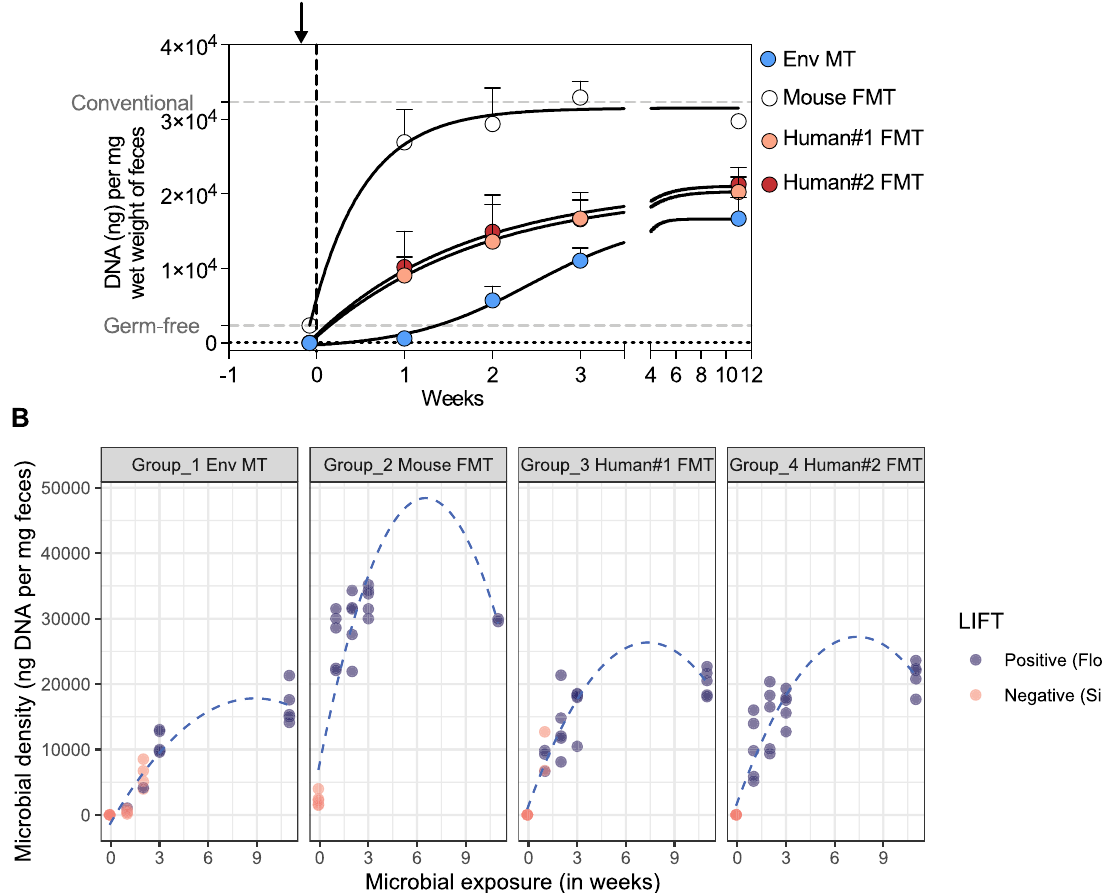
Figure 7. Levô in fimo test and gut microbial colonization kinetics. ( A ) Gut-colonization kinetics in Env MT, mouse FMT, human FMT#1, and human FMT#2 groups of mice. ( C ) Relationship between fecal microbiota density and fecal floatation instantly tested using LIFT in TFS. n = 5 fecal samples per group of 5 mice